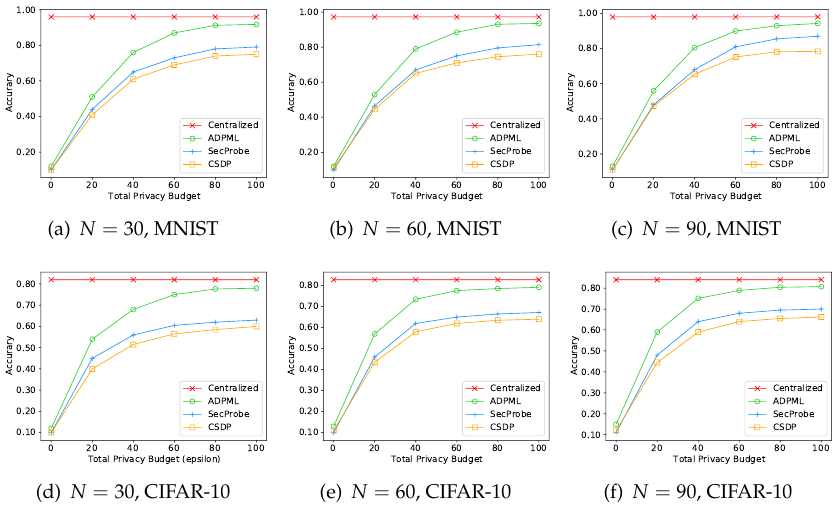
Figure 4. The model accuracy of different strategies for 30, 60, and 90 participants.